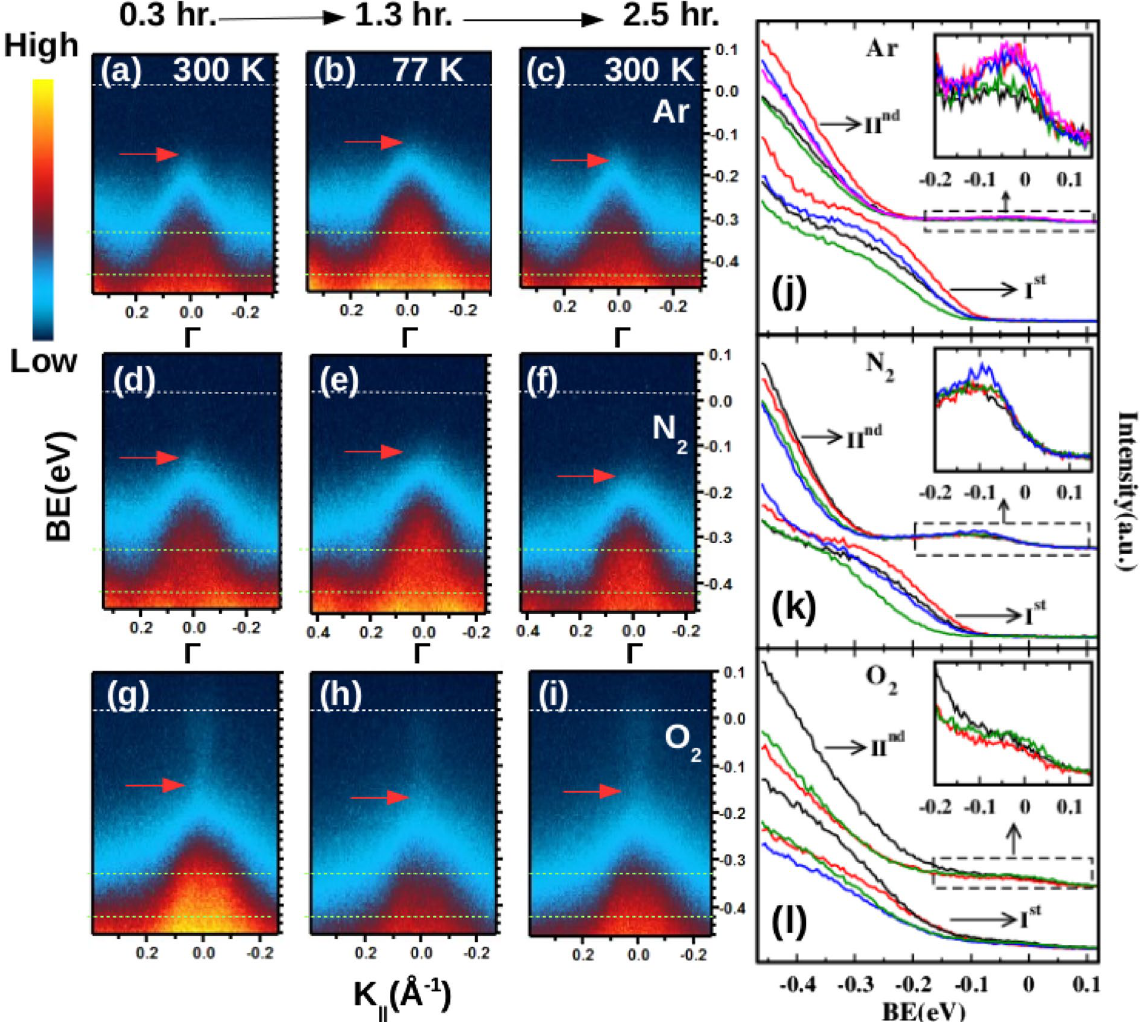
Figure 6. ( a,b and c ) show ARPES images taken at 300 K-77 K-300 K respectively just after the cleaving (I st thermal cycle) under constant Ar exposure. ( d – f and g – i ) display the ARPES images of the I st thermal cycle performed under constant dosing of N 2 and O 2 gases respectively. ( j , k and l ) correspond to the EDC (taken around the Γ point) plots of thermal cycling under the exposure of Ar, N 2 and O 2 gases respectively, where the inset of each plot shows the enlarged view of the near E f region. Different colours (black → red → green → blue → magenta) of the EDC spectra represent various stages (300 K → 77 K → 300 K → 77 K → 300 K) of thermal cycling